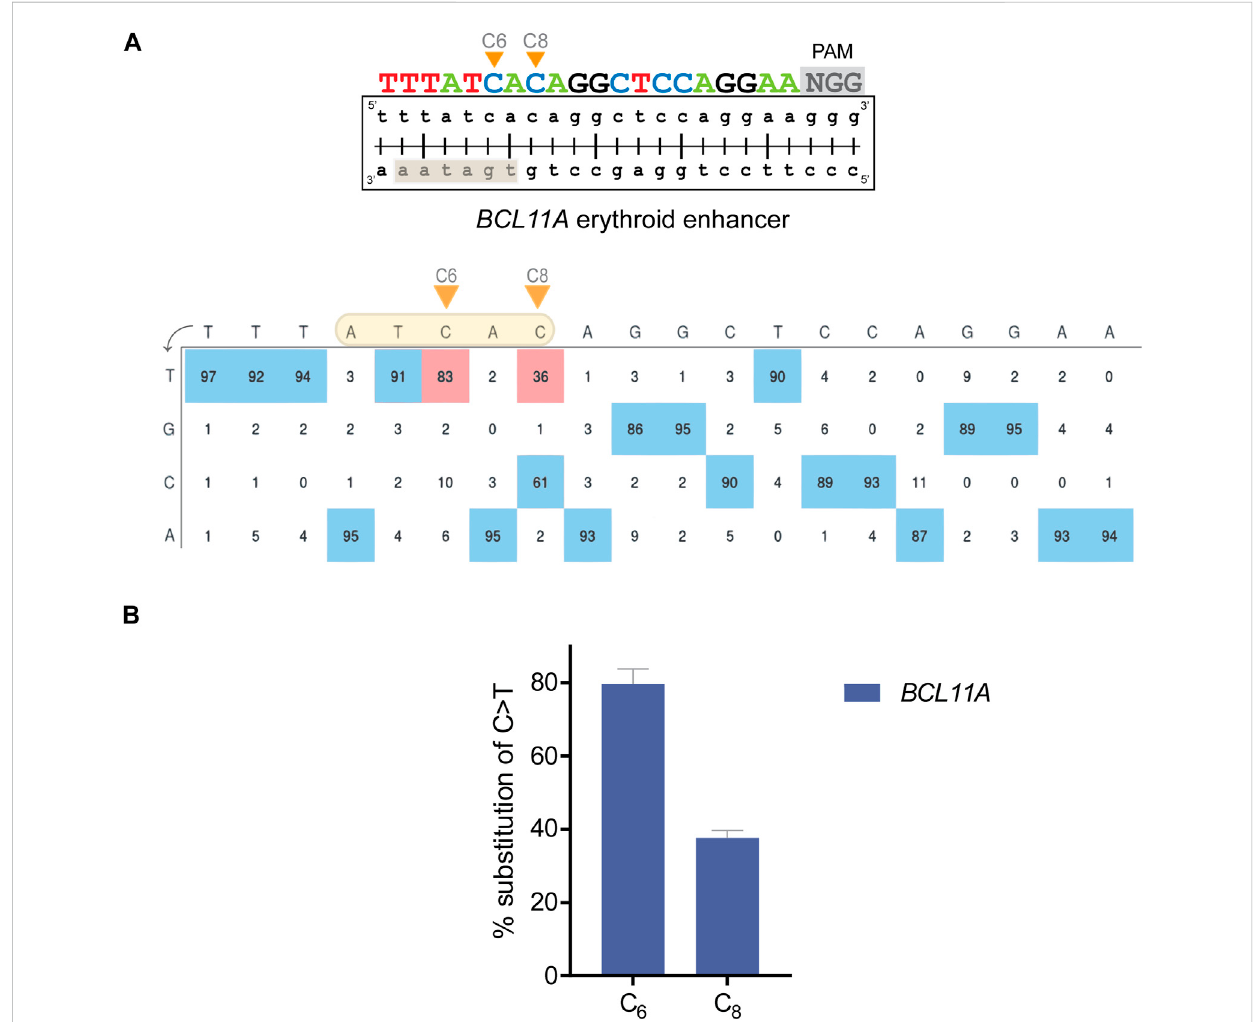
FIGURE 2 Editing ef fi ciency with BE in HUDEP-2 cells. (A) (top) Schematic diagram illustrating the BCL11A target with the DNA-equivalent of the 20-nt gRNA and the 3-nt PAM sequence. The orange arrows show the C bases that were edited. The highlighted rectangle indicates the WGATAR binding motif in BCL11A . (bottom) Annotated EditR-generated plot illustrating the percent area of the signal for each base (A | C | G | T) at the corresponding gRNA position for edited HUDEP-2 cells. The highlighted shape shows the editing window, the orange arrows show the edited C bases and the red boxes display the exact percentage (%) of base substitution in the bulk cell population. (B) Chart showing the % base substitution of C > T after base editing. Each bar shows the editing of the corresponding C base along the gRNA. The data are plotted as mean ± s.d. ( n =